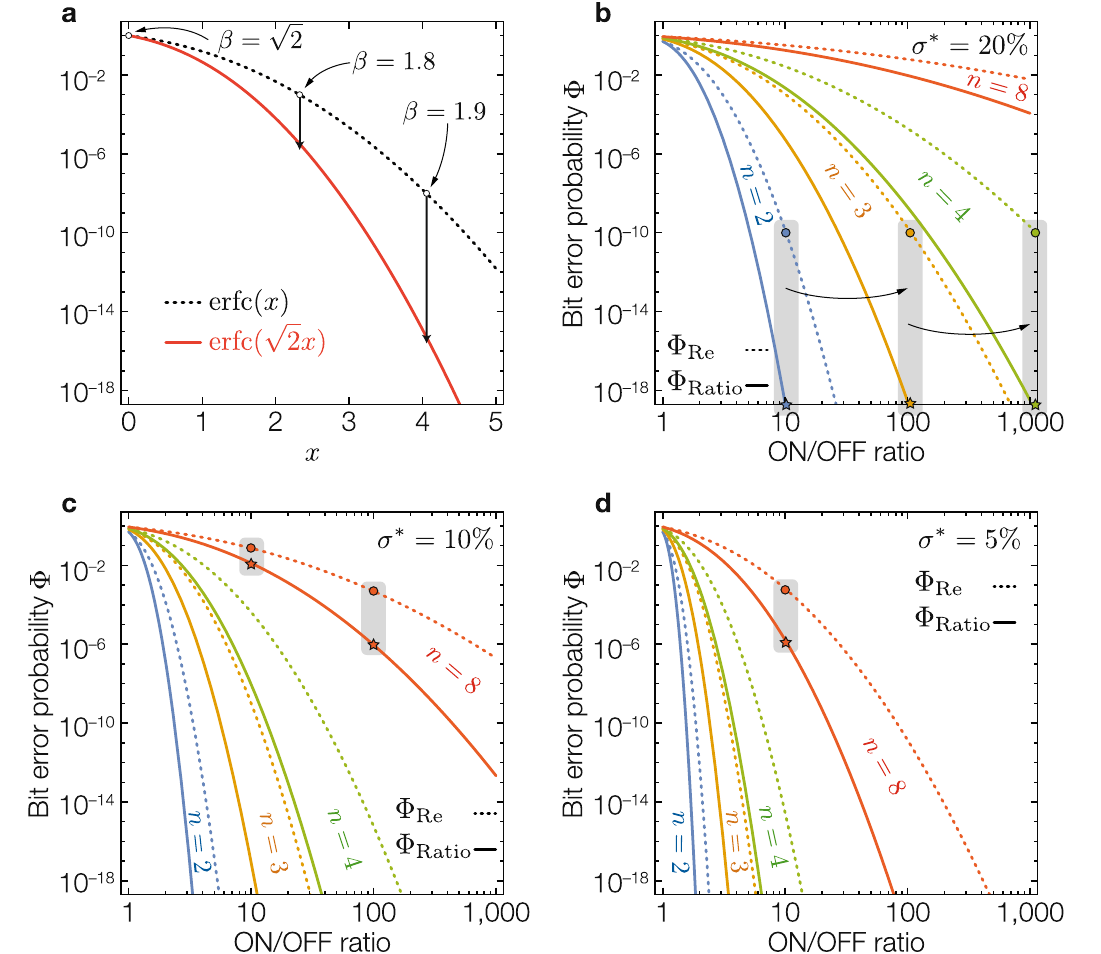
Figure 3. Bit error probability under different parameters. ( a ) Error function complement with a log-normal scale. ( b–d ) BEP for a geometric standard deviation of 20%, 10% and 5%, respectively, for 2, 3, 4 and 8 levels. Note that since σ ∗ is a multiplicative factor, a value of X % can be implicitly understood as 1 σ ∗ 10% we use σ ∗ 1.10 = =